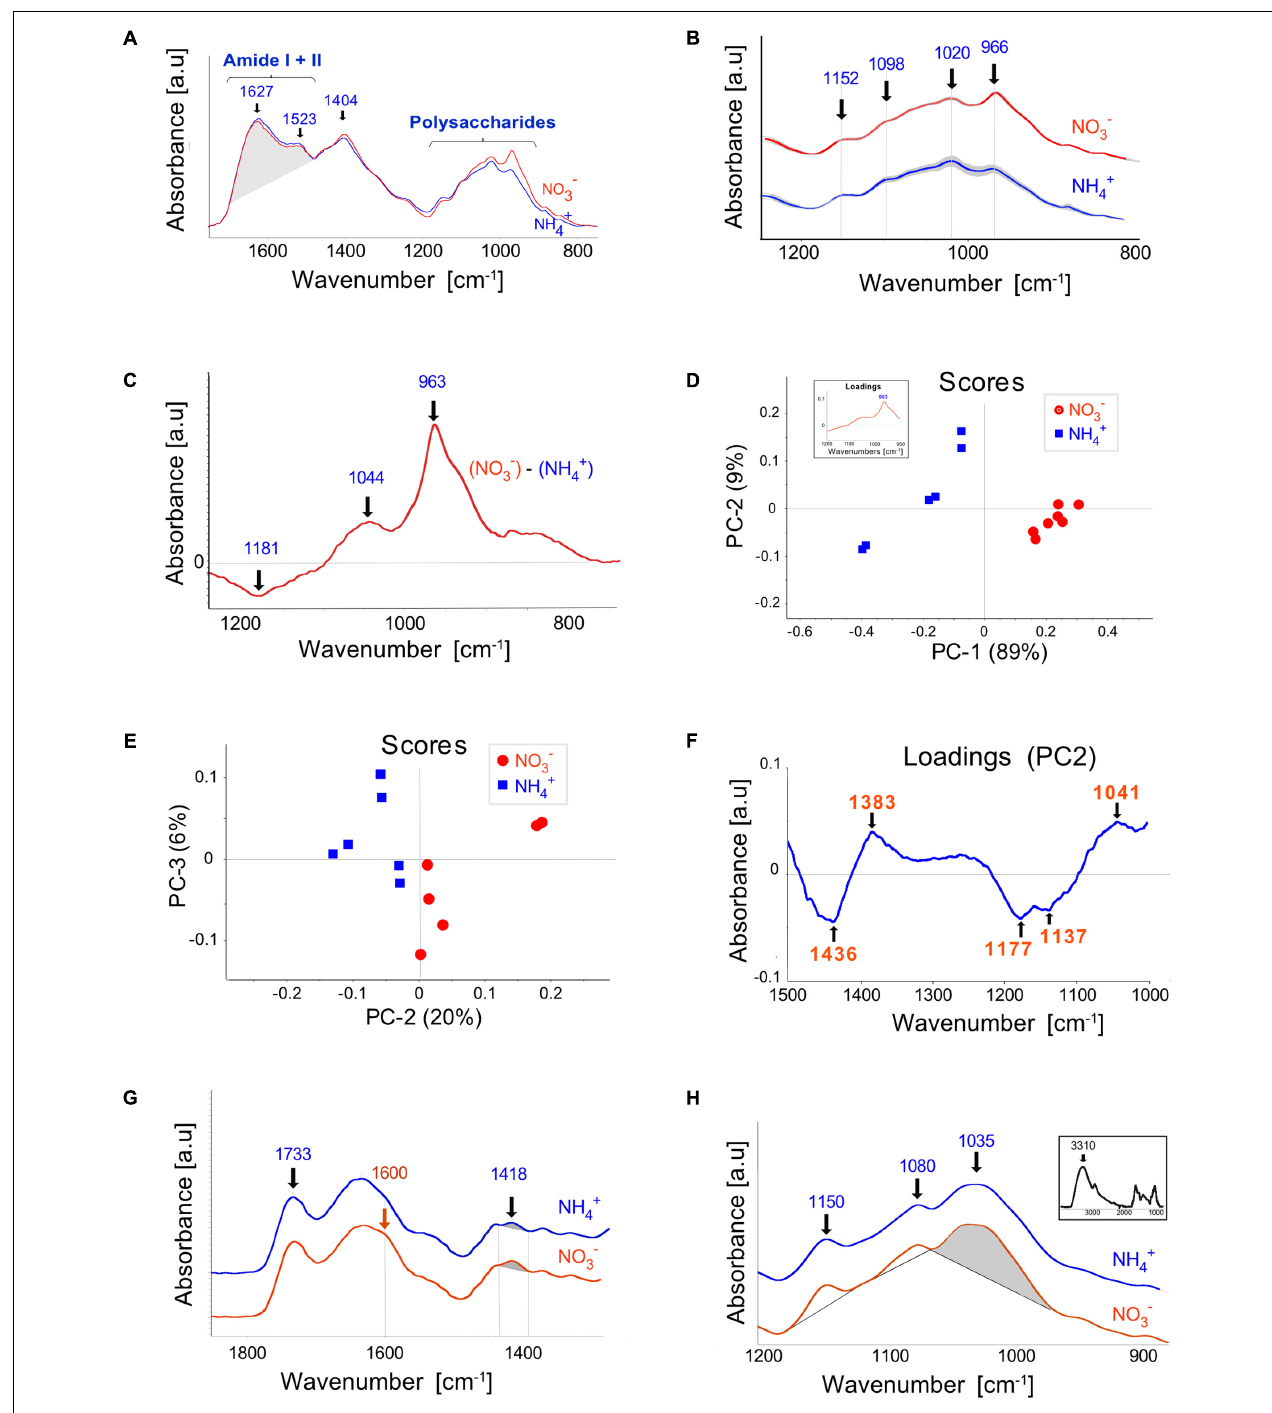
FIGURE 5 | Fourier Transform Infrared (FTIR) spectroscopy of cell walls extracted from leaves of Arabidopsis plants cultured on NH 4 + and NO 3 − (control). (A) The spectra for the Amide I + II and the fingerprint regions normalized for an equal area between 1,760 and 880 cm − 1 . (B) The mean spectra with SD (gray ribbon) for the polysaccharide region. For better readability, they were offset along the absorbance axis. (C) Differential mean spectrum of the cell wall obtained by subtraction the spectrum for plants grown on NH 4 + and NO 3 − . (D,E) PCA score plots discriminating plants growing on NH 4 + and NO 3 − . Principal component 1 (PC1) explained 89% of the total variability within the spectral range between 1,200 and 900 cm − 1 and PC2 explained 20% of the variability between 1500 and 1000 cm − 1 . Corresponding loadings are given as an inset in (D) and as the (F) . Infrared spectra of (G) pectin-enriched and (H) hemicellulose-enriched extracts, respectively. The inset in (H) shows the whole-range spectrum for hemicellulose-enriched extracts. The relevant wavenumbers are denoted in the figures or shaded. The means were calculated for three independent experiments and two technical replicates.